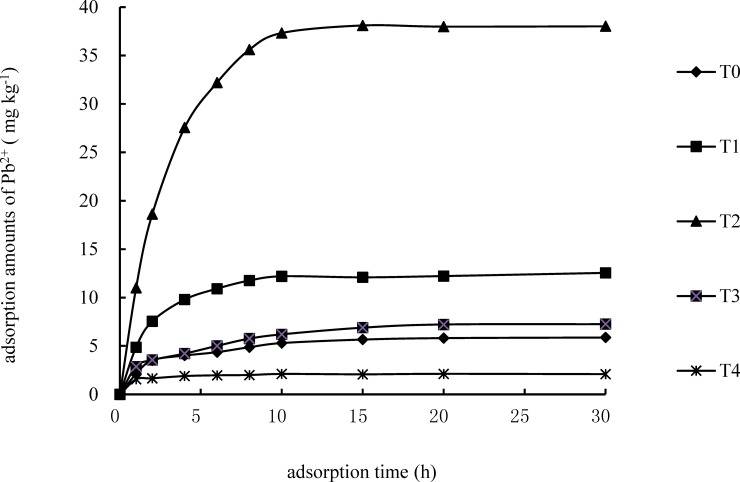
Adsorption dynamic curves of Pb2+ by ameliorated alum plasma and original alum plasma (Initial Pb2+ concentration in the solution is 20 mg·L−1; and the initial pH is 6.0).